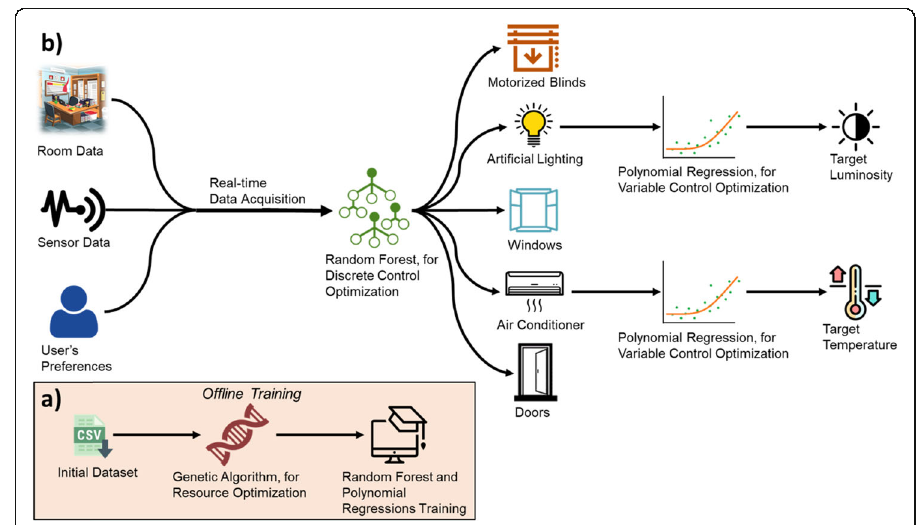
Fig. 1 Flowchart of the proposed solution: a) Initial training, b) Real-time